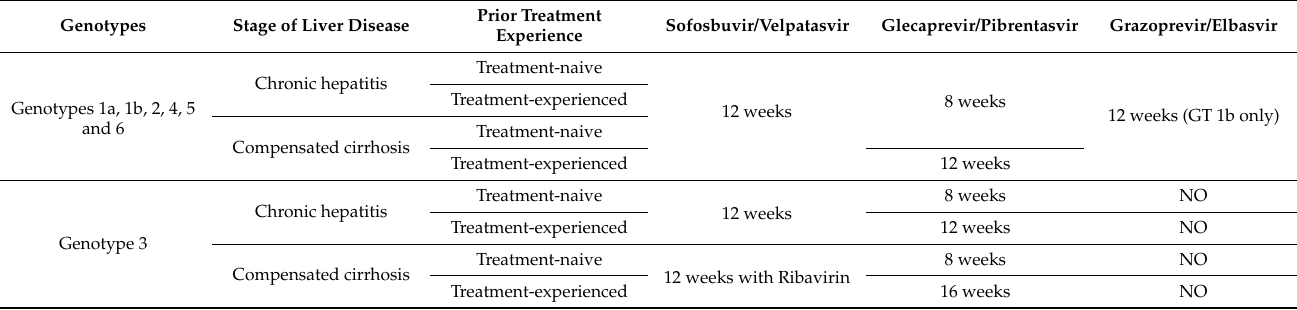
Table 2. Standard of care of patients with HCV infection